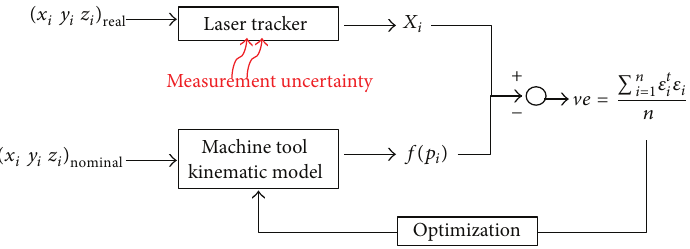
Figure 1: Basic parameters of volumetric